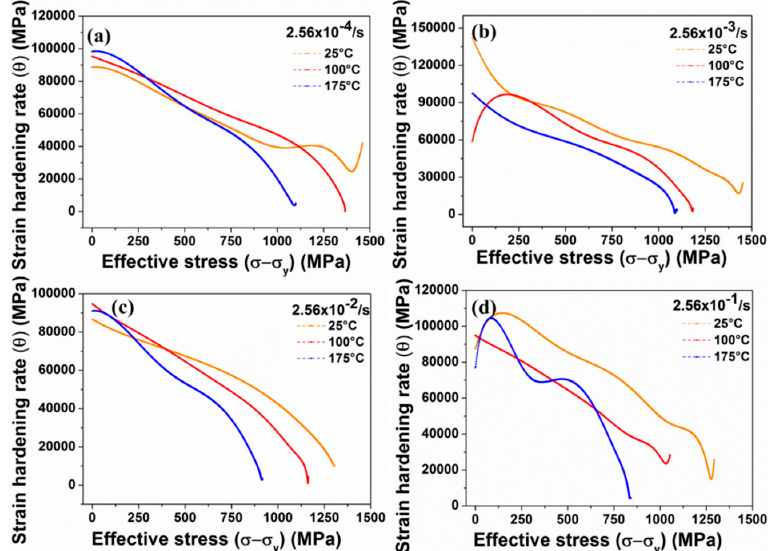
Figure 26. Strain-hardening rate as a function of effective stress at different temperatures and strain rates of ( a ) 2.56 × 10 − 4 /s, ( b ) 2.56 × 10 − 3 /s, ( c ) 2.56 × 10 − 2 /s, and ( d ) 2.56 × 10 − 1 /s [140] .